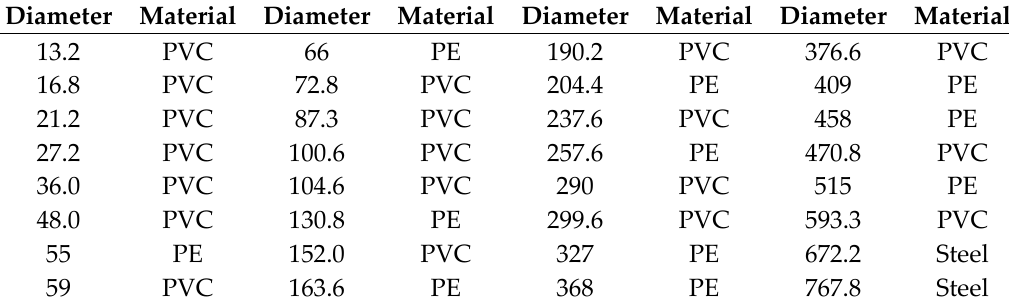
Table 1. Available internal pipe diameters (mm) and